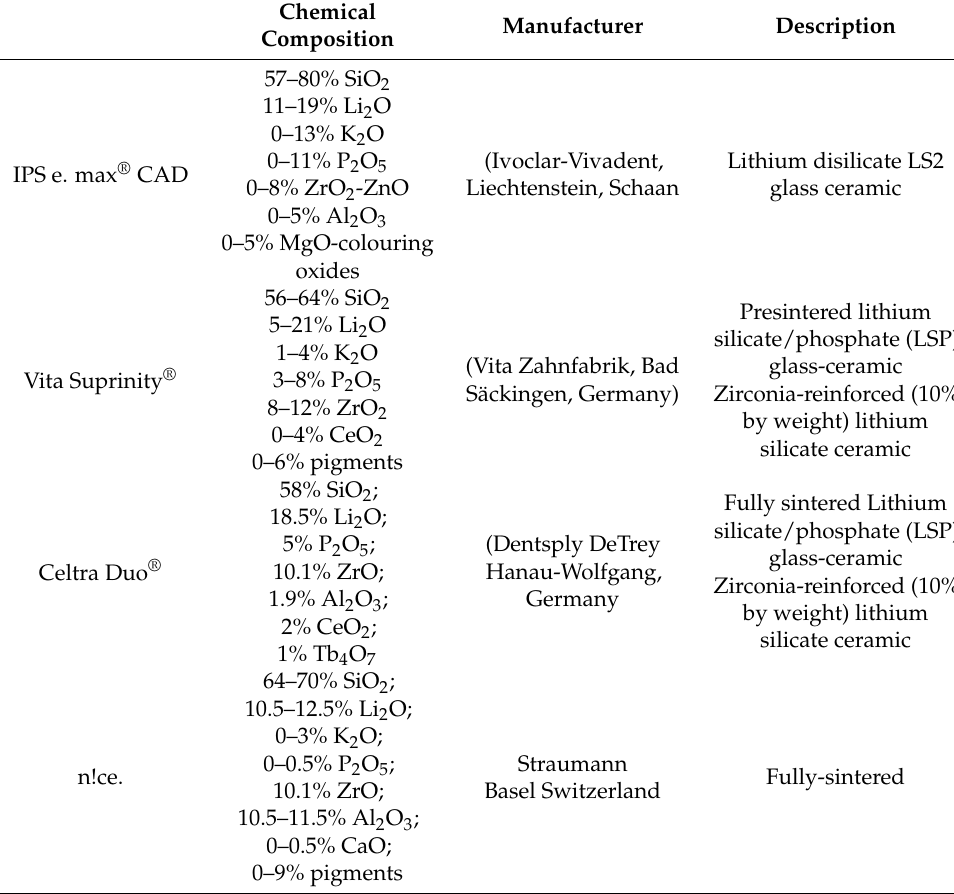
Table 1. The chemical composition, manufacturer information, and clinical information of the four LDGC used in this